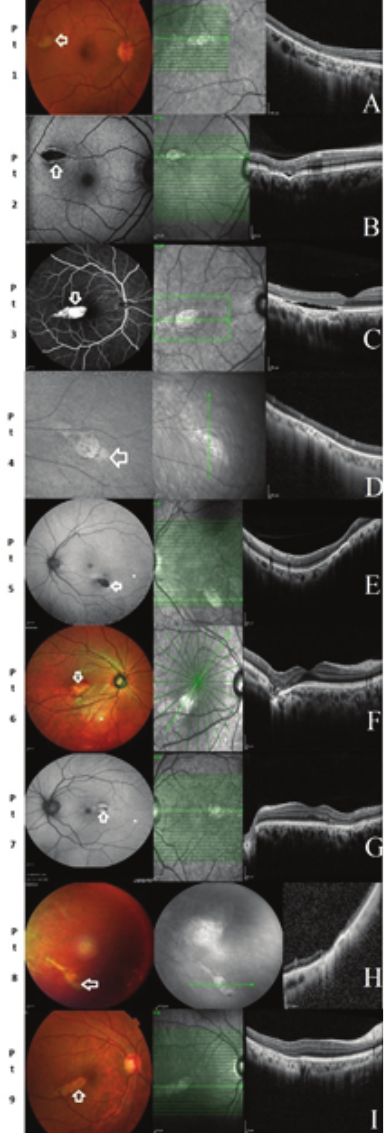
Figure 1. Fundus and OCT imaging of torpedo lesions (patients 1–9). The torpedo lesion in each panel is marked on the fundus image with white arrow. In panels, C, F, G and I, the torpedo lesion is located adjacent to the fovea. In panels B and E, the lesion is located adjacent to the macula but away from the fovea. In panel A, the lesion is just within the retinal arcade, and in panels D and H, the lesion is outside the retinal arcade. In every case, the OCT scan passing through the torpedo lesion is